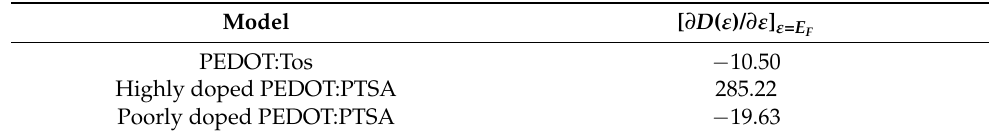
Table 1. [ ∂ D ( ε ) / ∂ε ] calculated from TDOS shown in Figure ε = E F